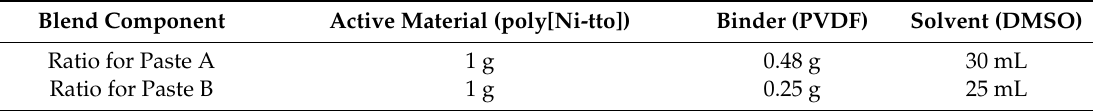
Figure 2. Rheological behaviour of two di ff erent pastes: A (top part) and B (bottom part): receiving of the rheological behaviour in the shear rate range of 0.1–1000 s − 1 (left side) and investigation of the thixotropic behaviour (right side) of the paste for the shear range 0.1 s − 1 (10 min)–100 s − 1 (30 s)–0.1s − 1 (10 min). Table 2. Samples of paste with di ff erent component